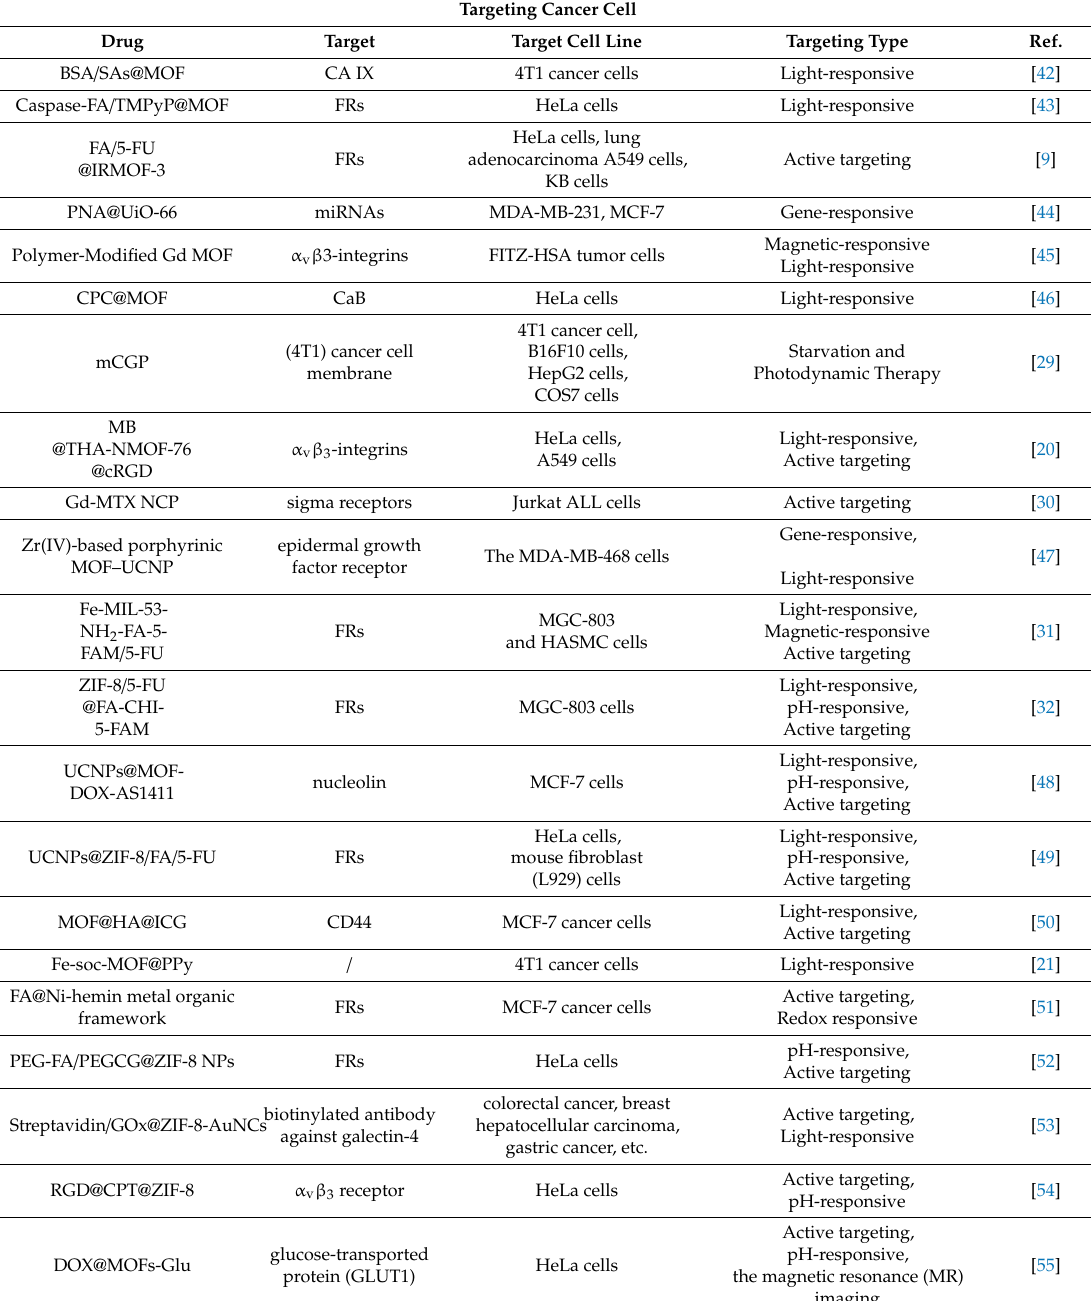
Table 3. Targeting strategies for metal organic